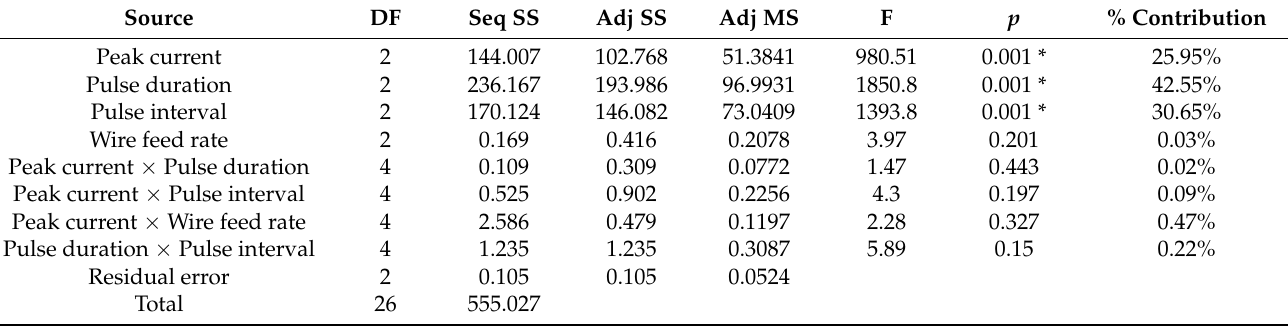
Figure 9. Main effects plot for Ra. Table 6. ANOVA table for MRR. (*significant parameters).